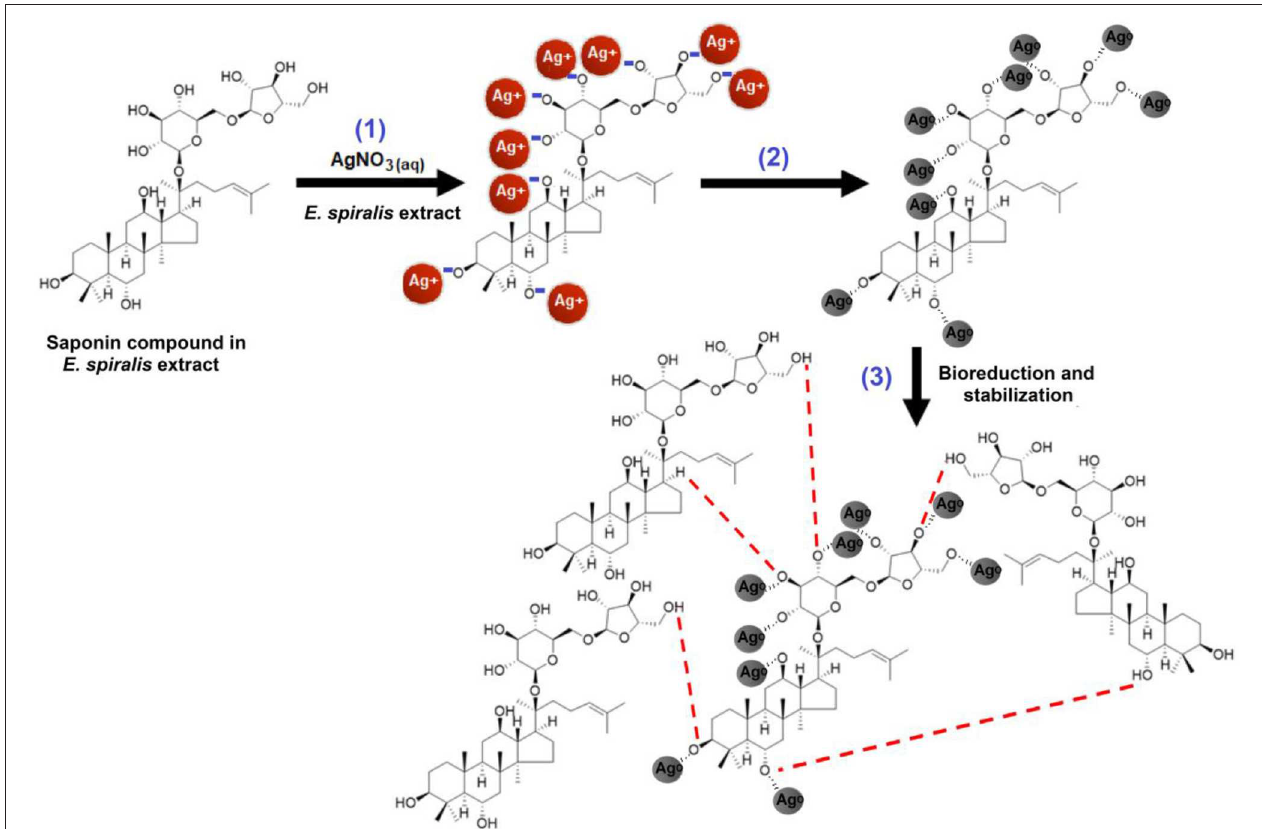
FIGURE 1 | The possible mechanism between the reducing agents in the E. spiralis extract to reduce Ag + ions to E. spiralis /Ag-NPs.